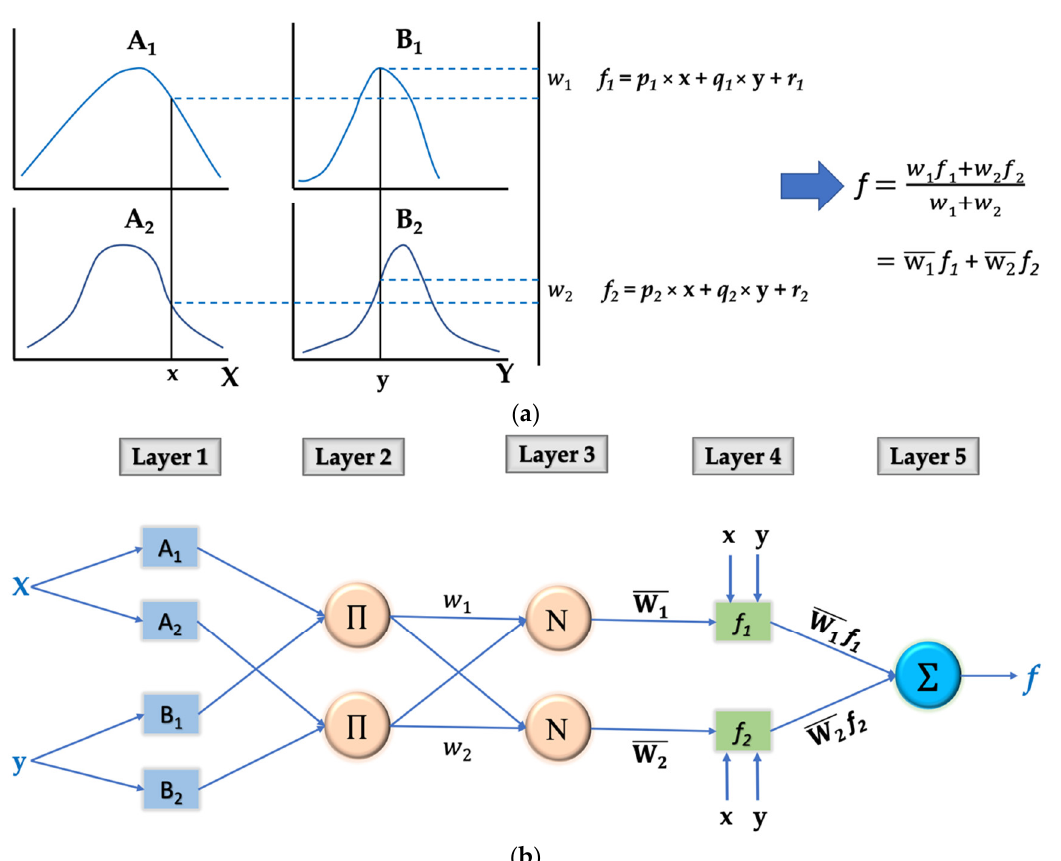
Figure 4. ( a ) A first-order Sugeno fuzzy model, ( b ) typical ANFIS architecture. Reprinted with permission from reference [31] Copyright 2013,